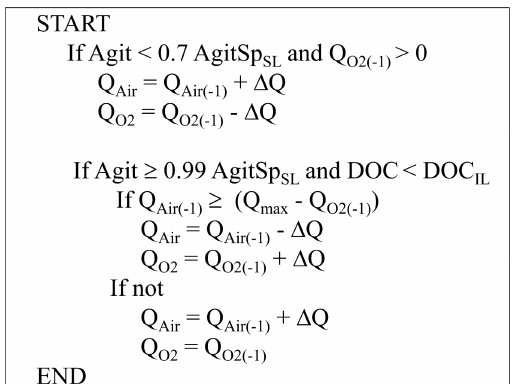
Figure 1. Decision tree for air and oxygen flow rates manipulation in